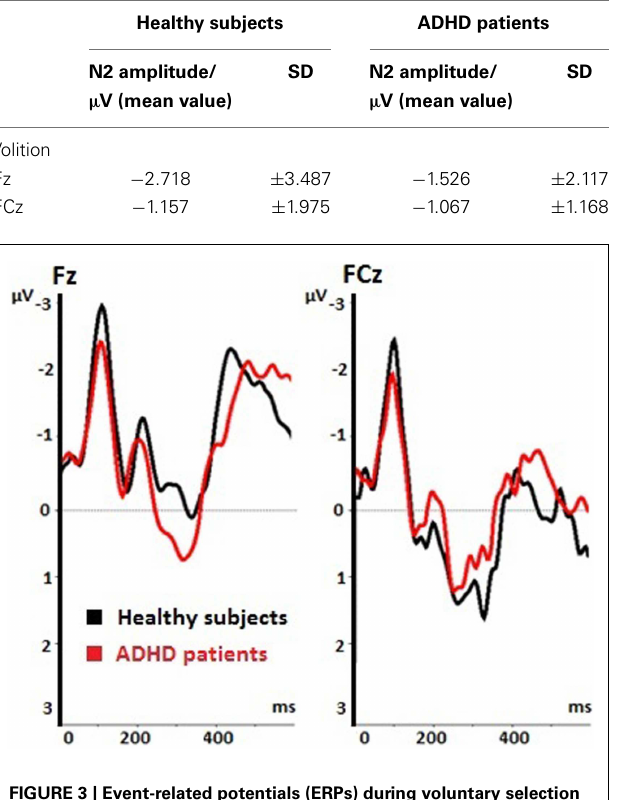
FIGURE 3 | Event-related potentials (ERPs) during voluntary selection condition in fronto-central electrodes (Fz, FCz) of healthy controls (black) andADHD patients (red); µ V, microvolt; ms, milliseconds .